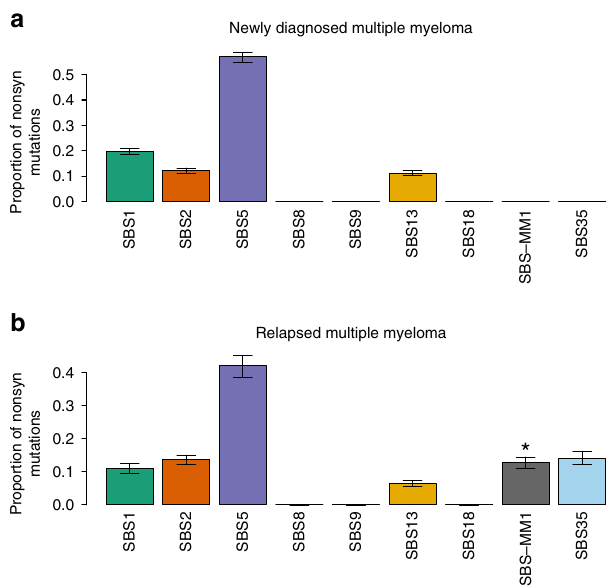
Fig. 5 The mutational signature landscape of nonsynonymous mutations in MM. Contribution of each MM mutational signature among nonsynonymous (nonsyn) mutations at diagnosis ( a ) and relapse ( b ). (SBS-MM1 = melphalan-associated signature; SBS35 = platinum-based chemotherapy associated signature). The asterisk re fl ects the presence of transcriptional strand bias for SBS-MM1. Con fi dence interval of each mutational signature was generated by drawing 1000 mutational pro fi les from the multinomial distribution, each time repeating the signature fi tting procedure, and fi nally taking the 2.5th and 97.5th percentile for each